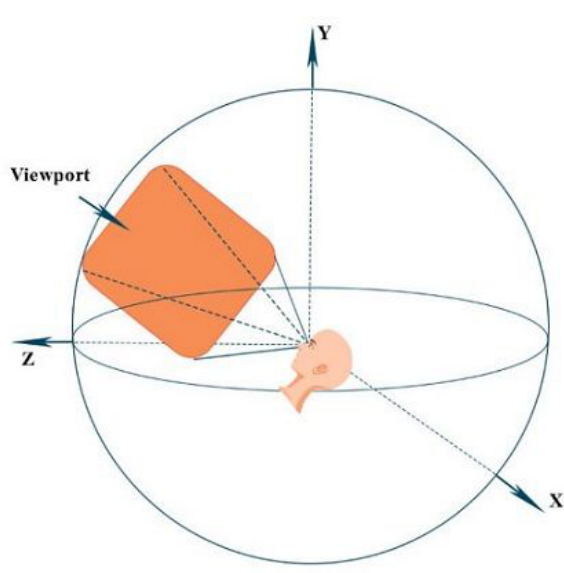
Figure 2. The viewport of a user at a time